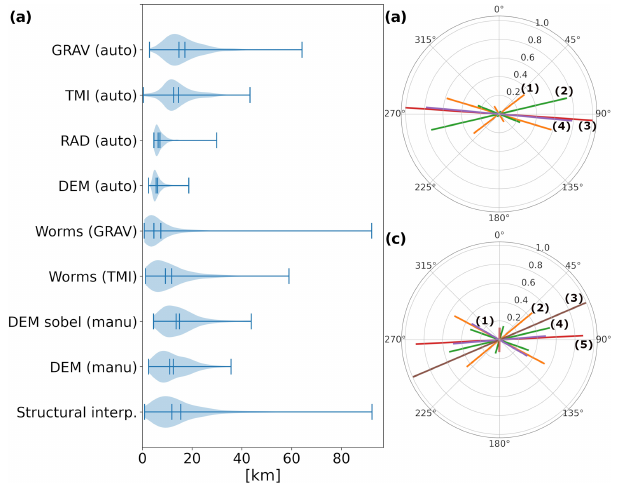
Figure 11. (a) Violin plots showing kernel density estimates of the lineament length distributions. Minimum, maximum, mean, and median values are shown as vertical lines for each distribution. Plots were generated using the Python library at https://matplotlib.